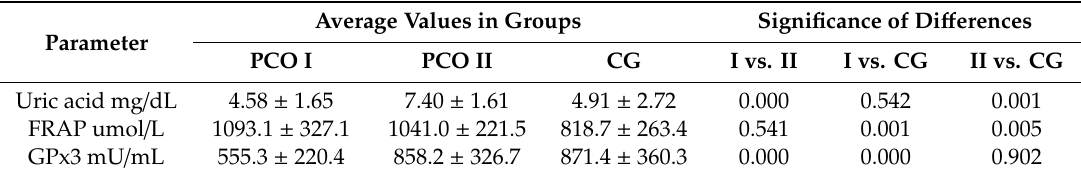
Table 1. Changes in concentrations of antioxidants (uric acid, FRAP, GPx3) in the plasma of women with PCOS before and after following a low GI, low-calorie diet.